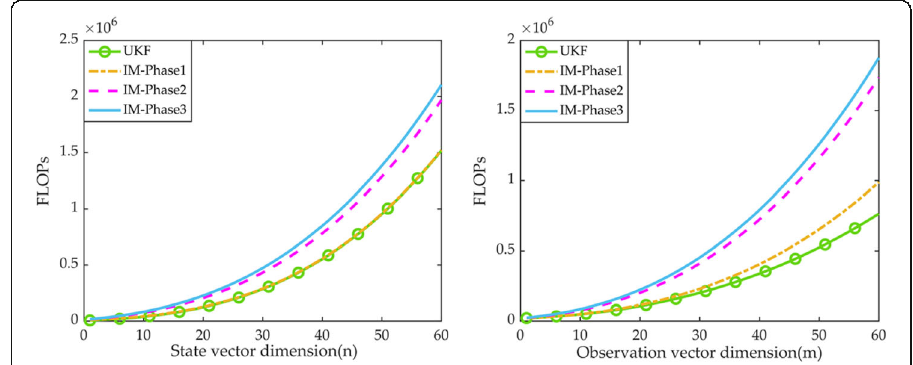
Fig. 7 Computational complexity in FLOPs of different state and observation dimensions. a Observation vector dimension m = 20, n varies from 1 to 60. b State vector dimension n = 20, m varies from 1 to